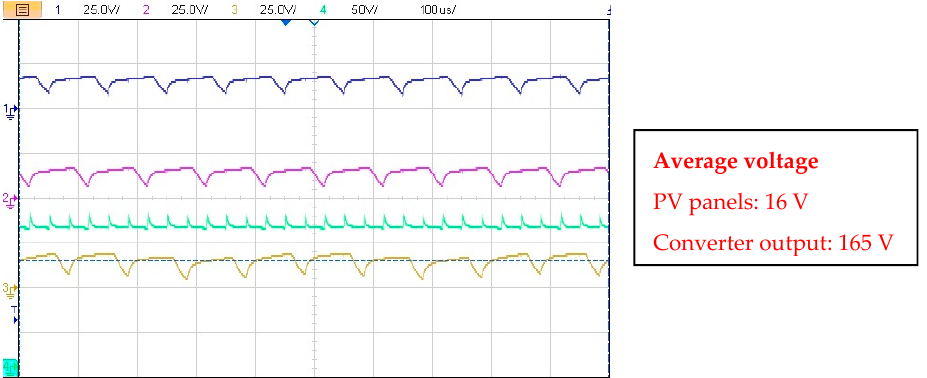
Figure 23. Experimental waveforms near sunset: Input voltages: PV panel 1 (blue), PV panel 2 (pink), and PV panel 3 (yellow); scale: 25 V/div. Converter output voltage (green); scale: 50 V/div. Base time 100 µs/div.